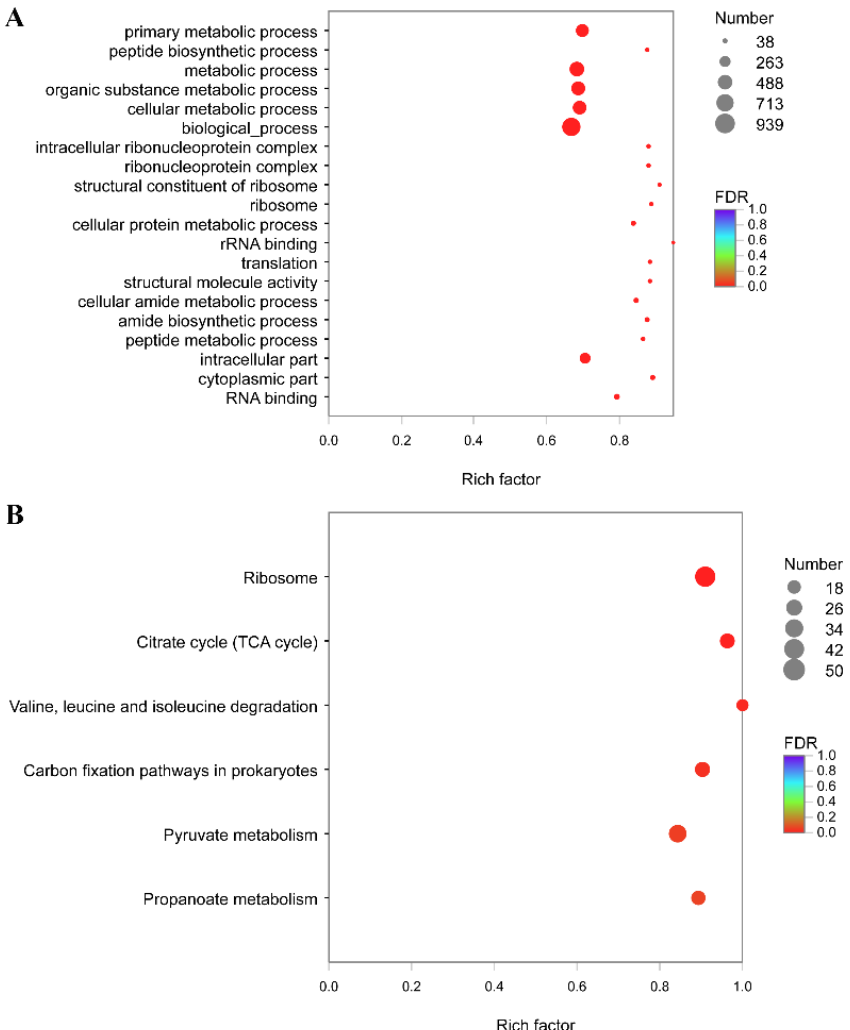
Figure 4. Analysis of differentially expressed genes between 18 and 28 °C. ( A ) GO terms of DEGs between 18 and 28 °C were classified based on their molecular functions, involvement of biological processes and cellular components. The size of the dot indicates the number of genes/transcripts in this GO Term, and the color of the dot corresponds to different FDR ranges. ( B ) KEGG enrichment of differentially expressed genes between 18 and 28 °C. The size of the dot indicates the number of genes in this pathway, and the color of the dot corresponds to different q ‐ value ranges.